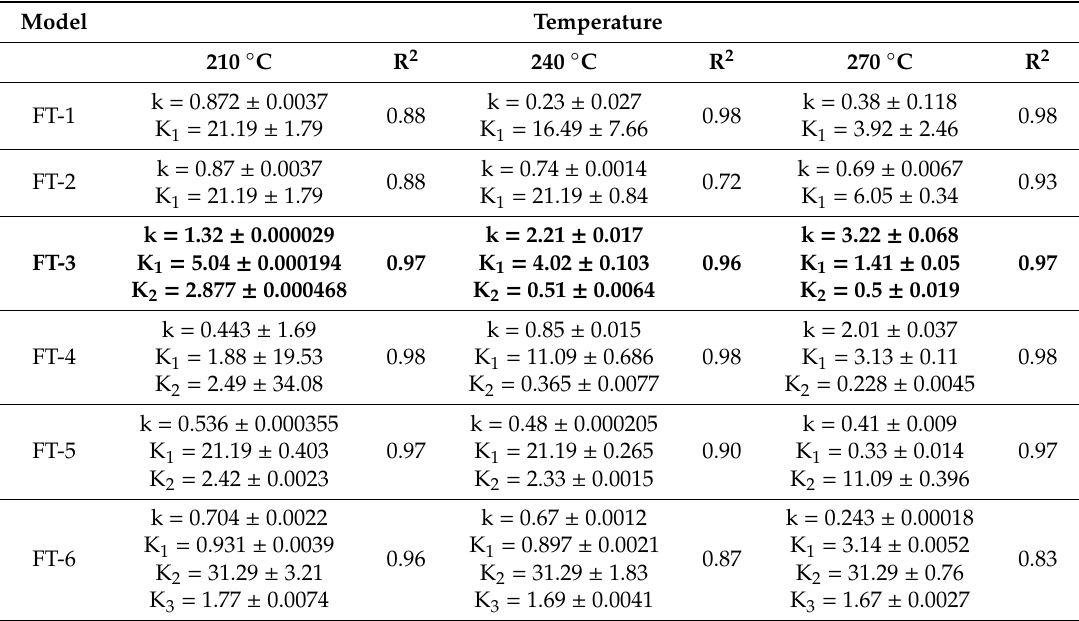
Table 5. Kinetic parameters obtained from proposed mechanisms for